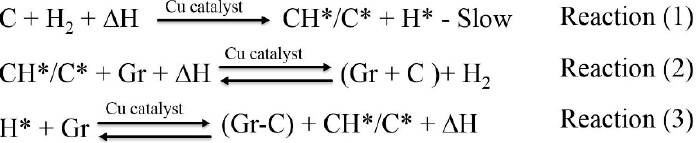
Table 4. Analysis of variance for I 2D / I G using adjusted SS for the tests. The texts marked in red represent statistically ‐ significant terms.